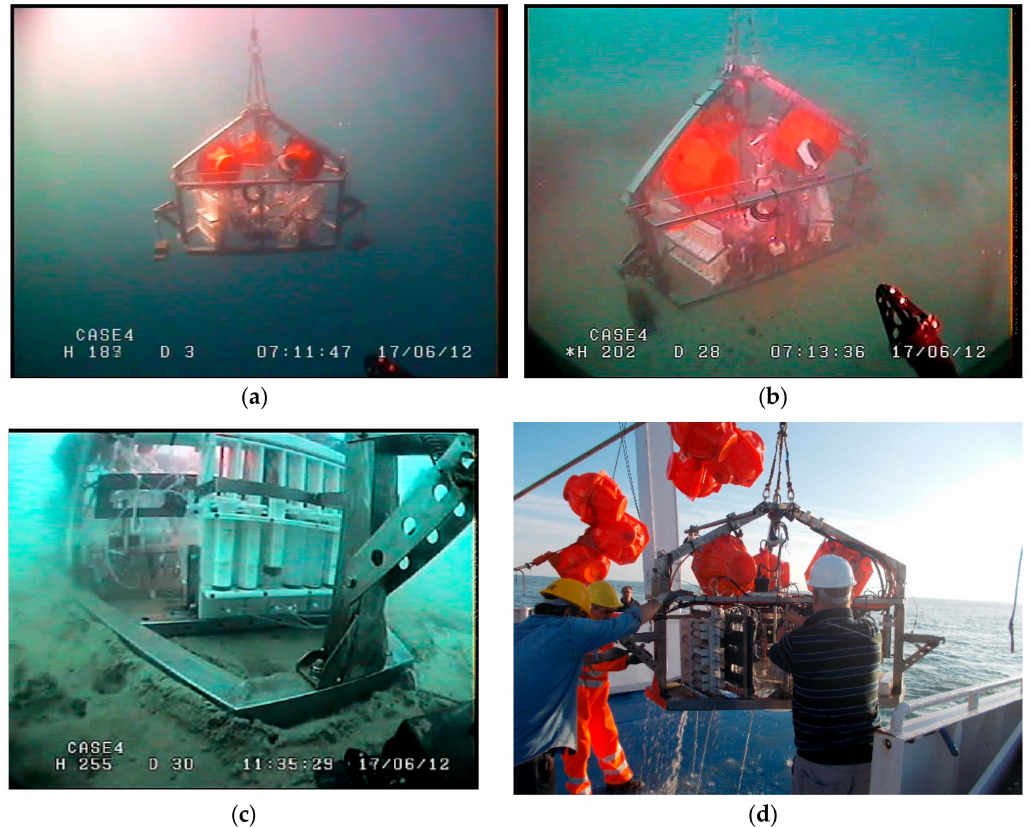
Figure 13. The Amerigo Lander photographed in some operational phases: ( a ) In the water before release; ( b ) on the seabed (view from above); ( c ) on the seabed (lateral view); and ( d ) on board after